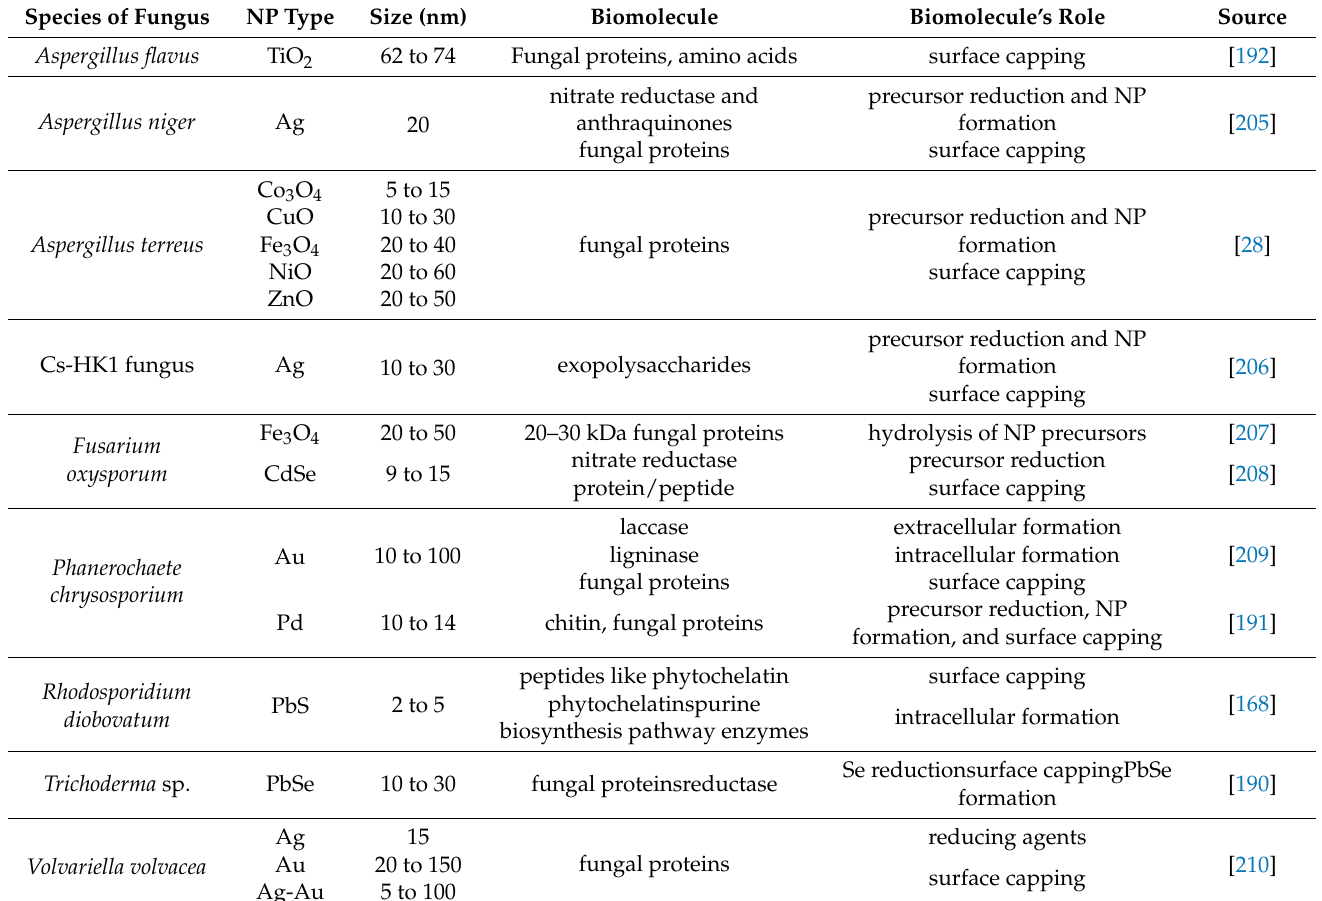
Table 1. Selected examples of biomolecules used in the synthesis of various metal-containing